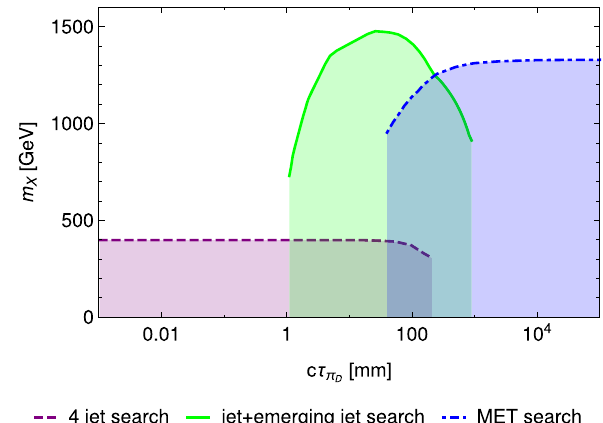
Fig. 12 Constraintsonthemassofa t -channelmediator (cid:10) (herecalled X ) as a function of the dark sector particle lifetime. See text for details. Figure taken from